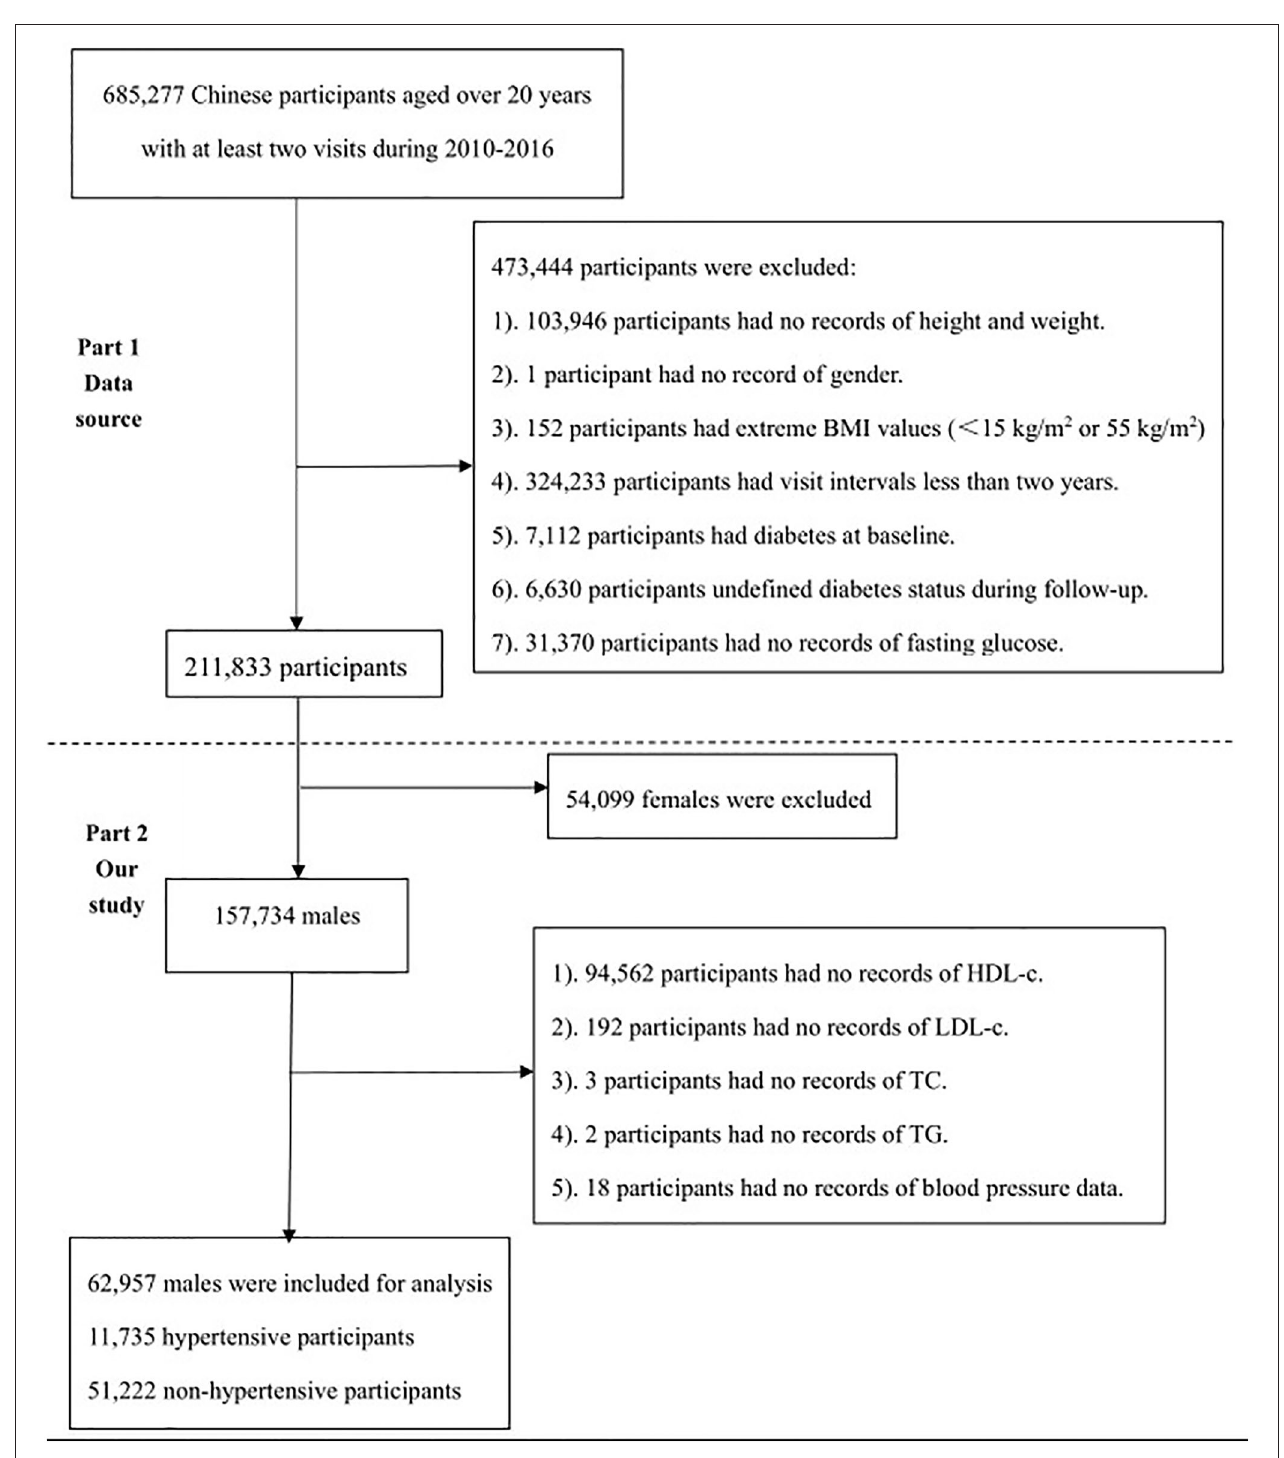
FIGURE 1 | The flowchart of study